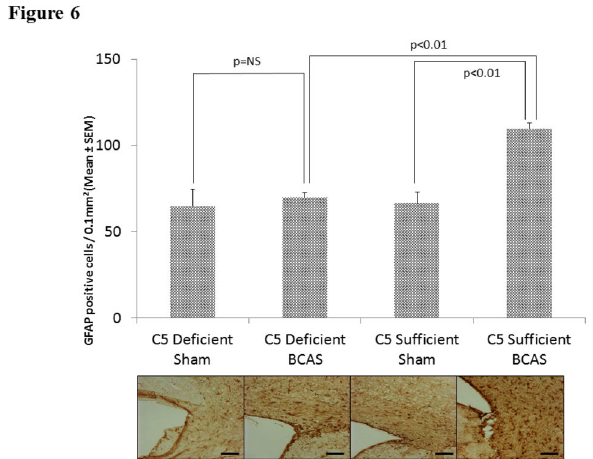
Figure 6. Reactive Astrocytes: GFAP staining for reactive astrocytes in the medial corpus callosum in C5 sufficient and C5 deficient mice subjected to sham and BCAS operations. Above: GFAP positive cell counts in each experimental group. Below: Representative coronal sections of the right corpus callosum with high magnification insert (medial corpus callosum). Bars indicate 50µm. n=10 C5D/ BCAS, n=10 C5D/ sham, n=9 C5S/ BCAS, n=9 C5S/ sham. doi: